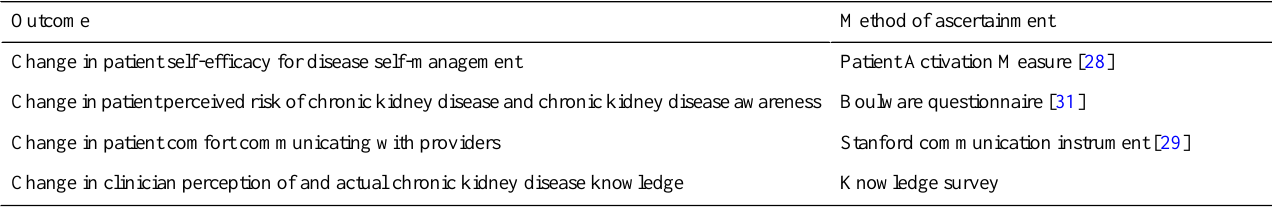
Table 2. Patient and clinician behavior outcomes.